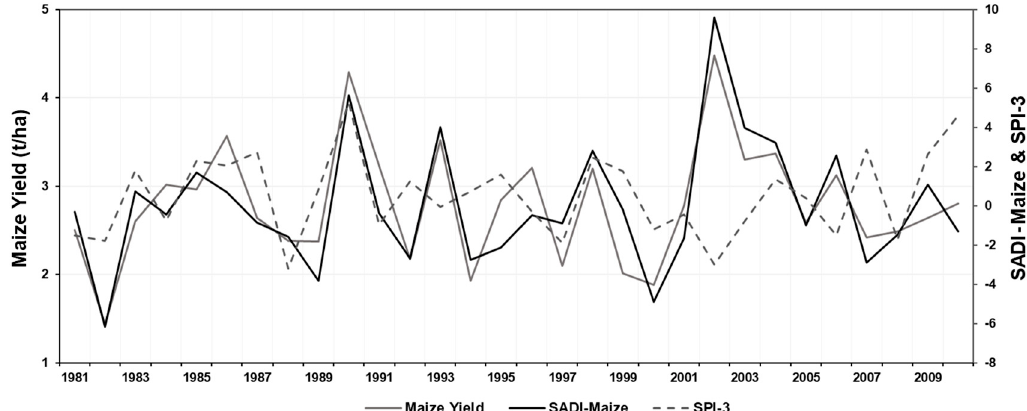
Figure 3. Annual comparison of the Standardized Agricultural Drought Index for rice (SADI-Rice), three-month Standardized Precipitation Index (SPI-3), and rainfed rice yield (1981–2010).